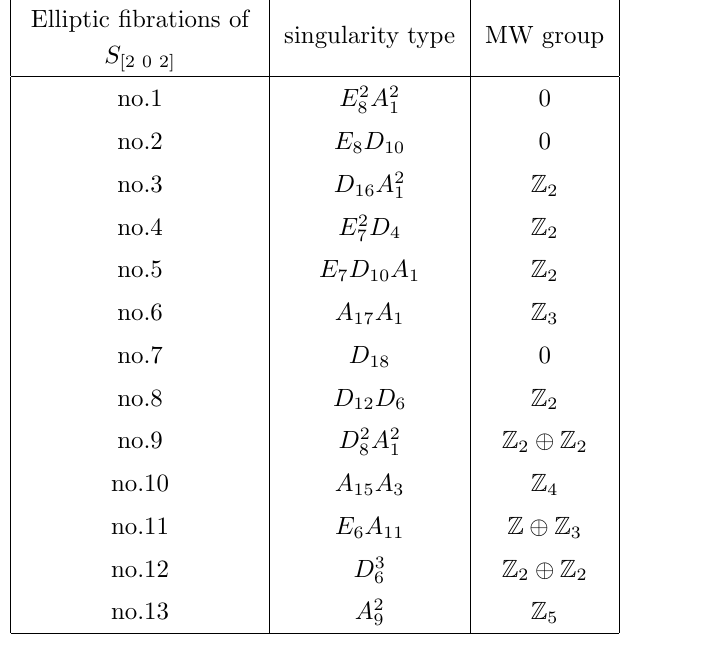
Table 5 . Elliptic (cid:12)brations of the attractive K3 surface S and the Mordell-Weil